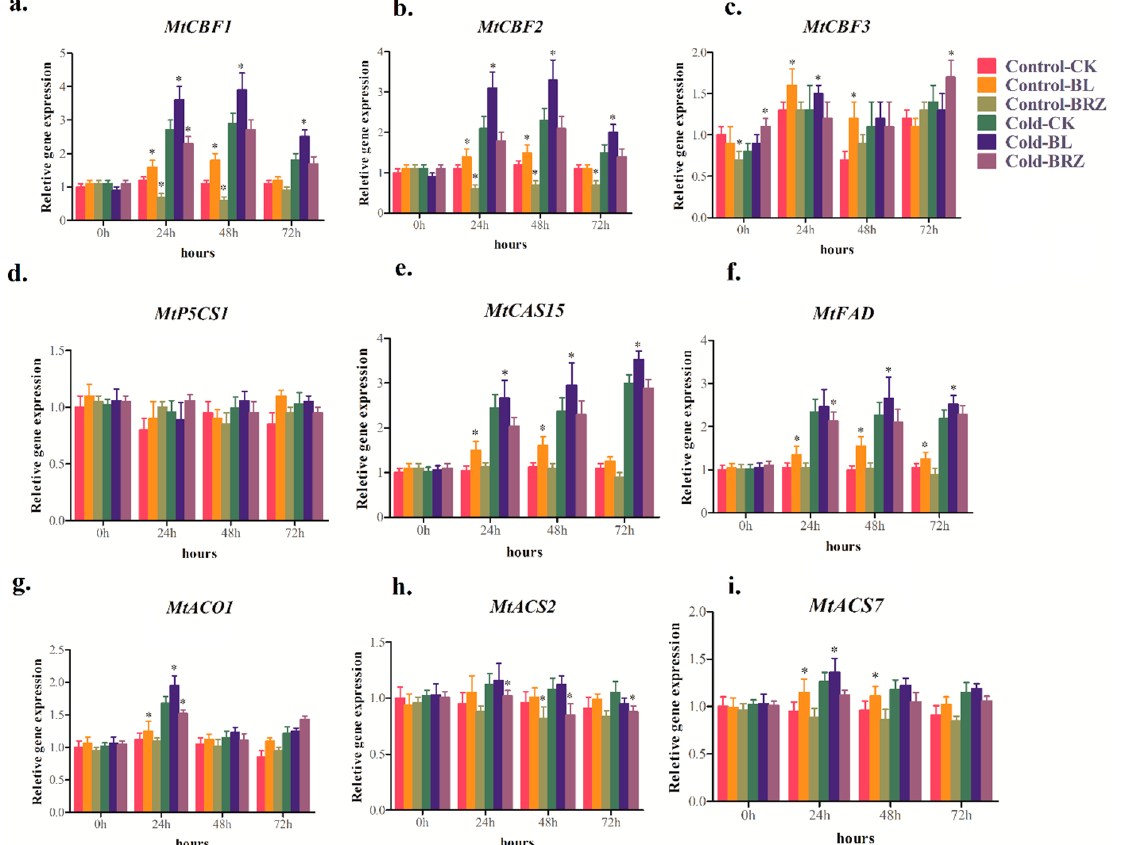
Figure 2. Response of several cold-related genes ( a – i ) was determined using quantitative RT-PCR. Plants were pretreated with 1 µ M BL or 1 µ M BRZ or water (CK) to investigate BRs effect. Bars represent the mean and standard deviation of values obtained from three biological replicates. Significant differences ( p < 0.05) are denoted by asterisks.